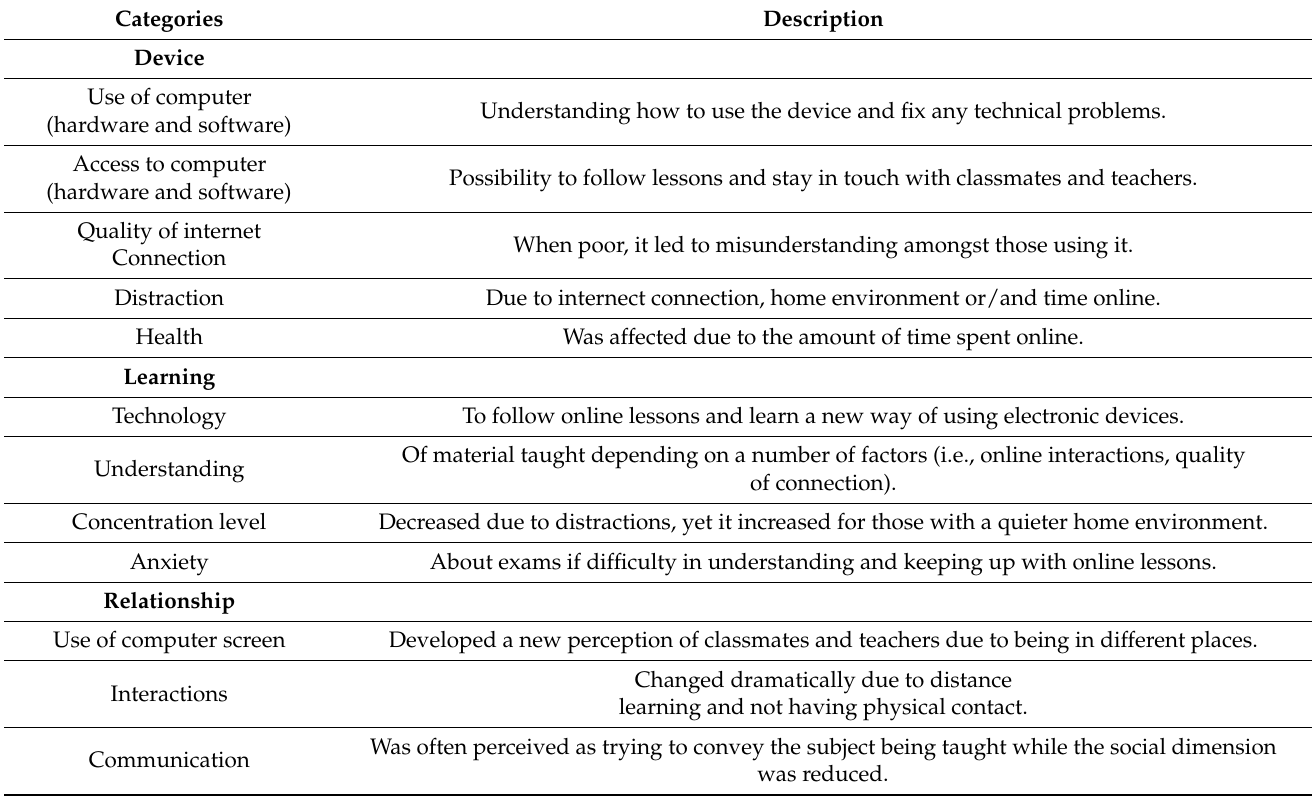
Table 1. Summary of the coding grid for each of the